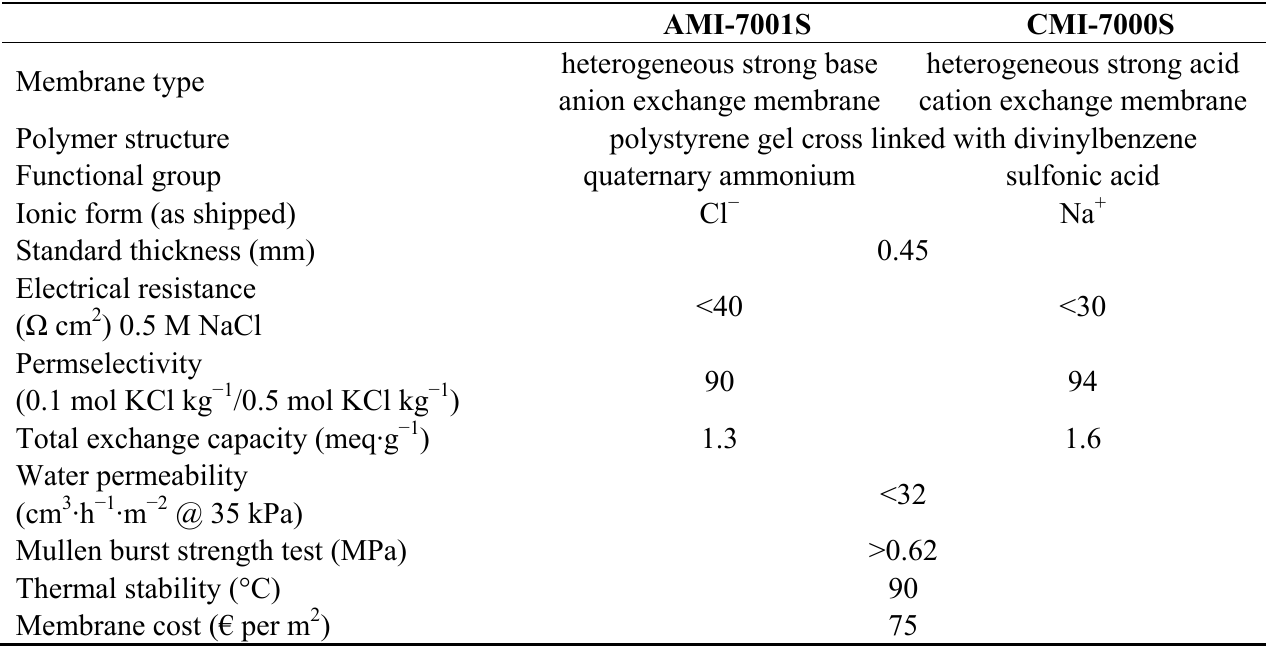
Table 1. Relevant properties of the two studied membrane